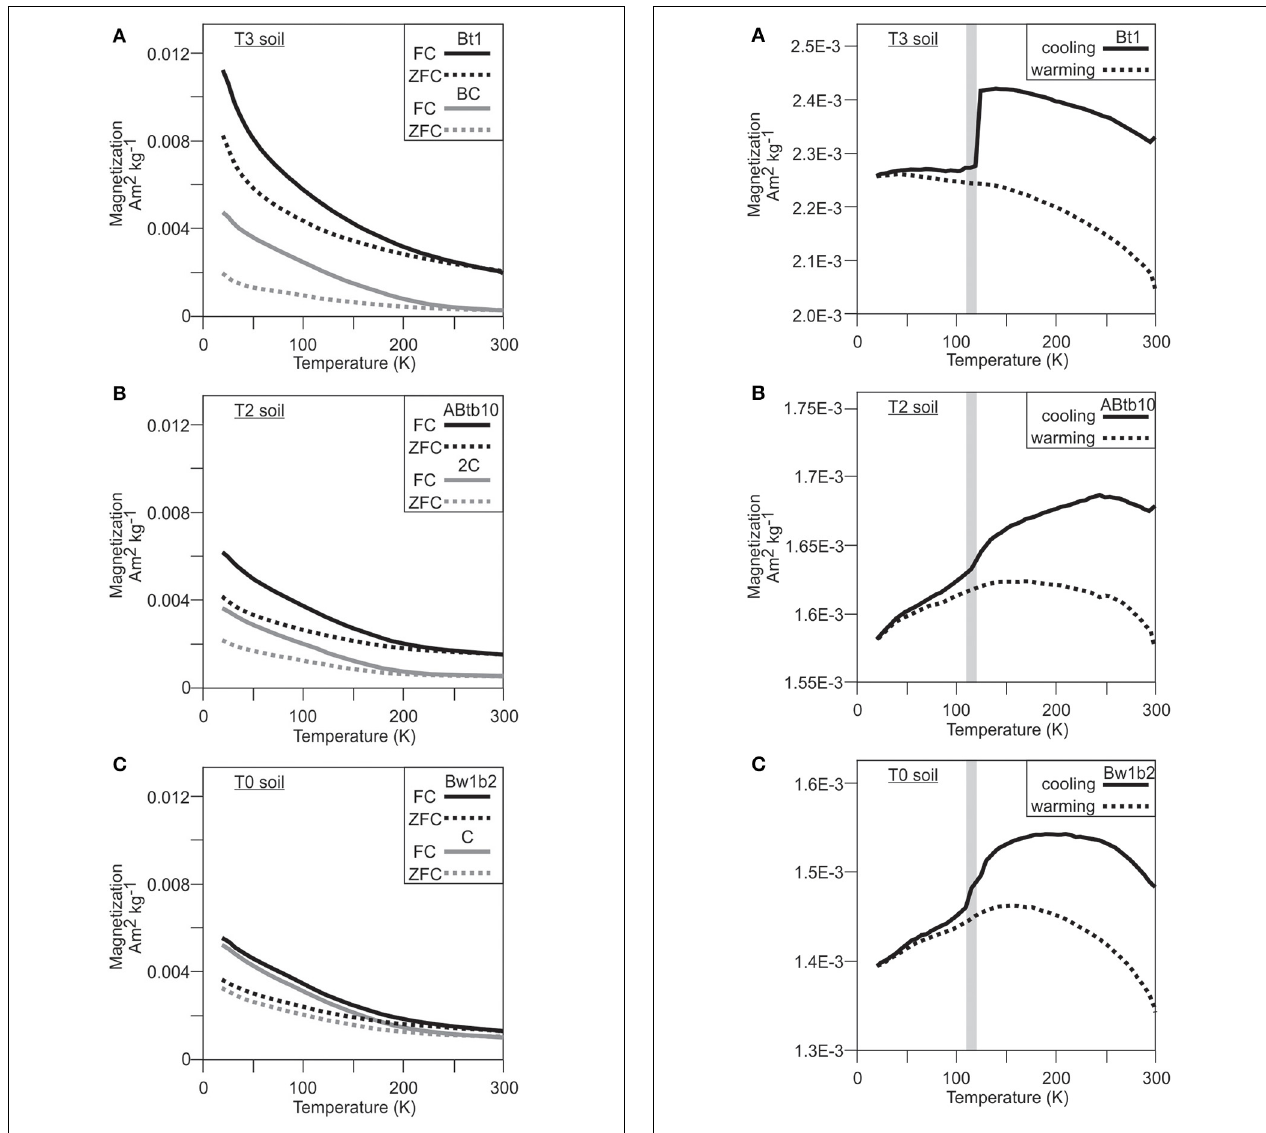
FIGURE 8 | Field-cooled (FC) and zero-field cooled (ZFC) remanence curves from (A) T3, (B) T2, and (C) T0 soil horizons.